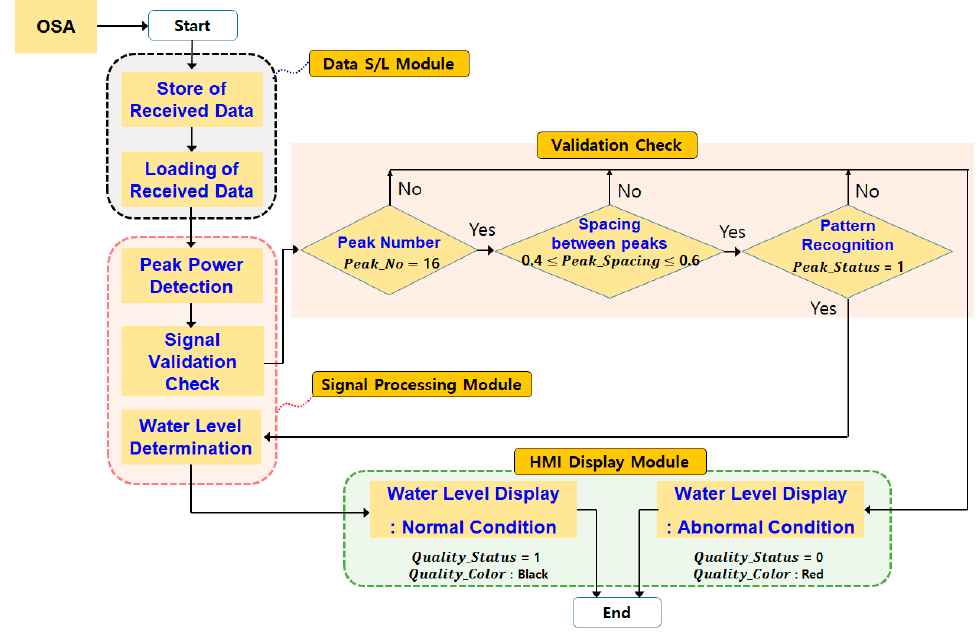
Figure 6. The flow chart for water level determination.